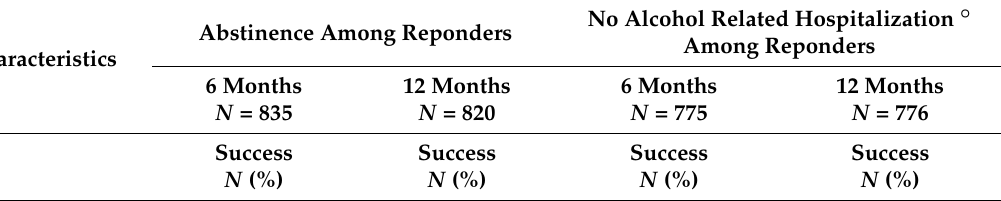
Table A1. Proportion of outcomes among responders according to several sociodemographic and clinical characteristics and the number of treatment strategies at 6 and 12